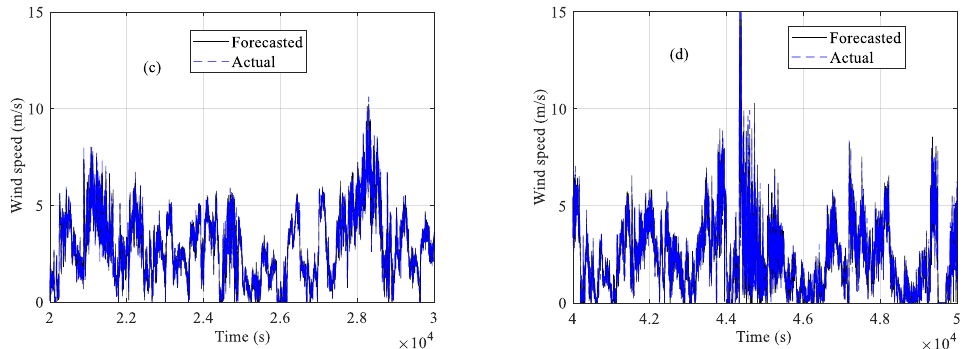
Figure 9. Forecasted and actual series of the test set referring to the 1-min-ahead prediction horizon for all the examined time period ( a ), between 0 and 10,000 s ( b ), between 20,000 and 30,000 s ( c ), and between 40,000 and 50,000 s ( d ).